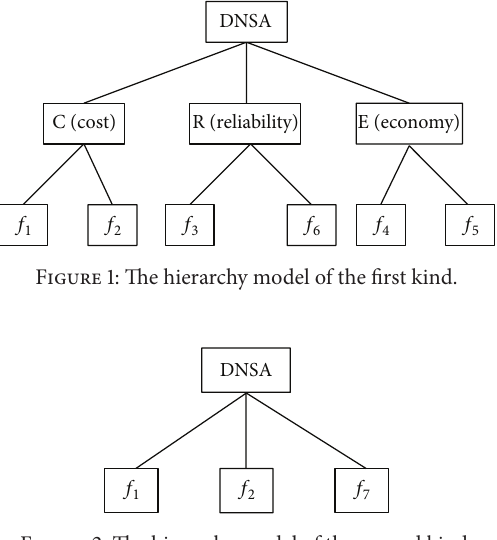
Figure 2: The hierarchy model of the second